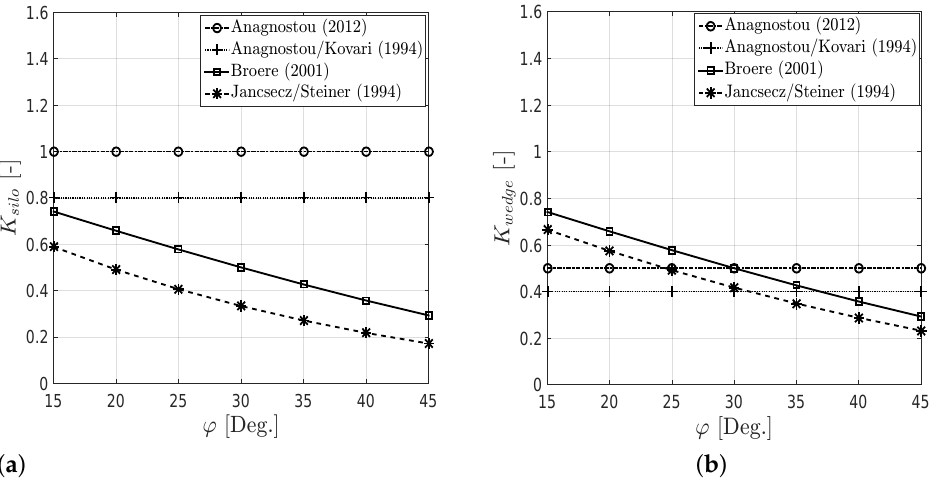
Figure 2. K silo and K wedge for different friction angles assumed by various approaches ( a ) Variation of K silo with friction angle ( b ) Variation of K wedge with friction